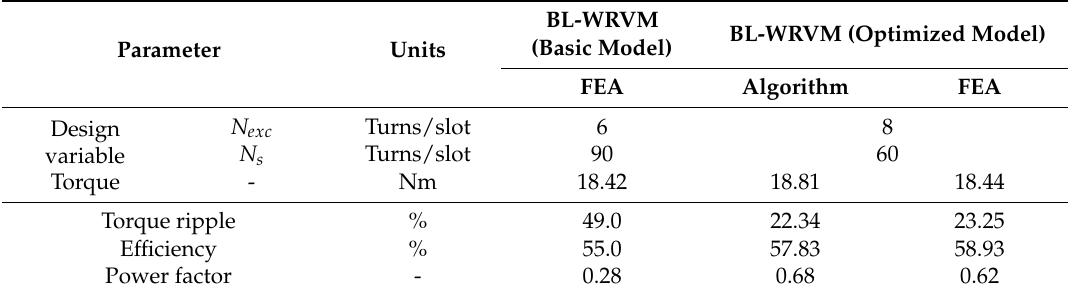
Table 3. Performance comparison of the basic and optimized